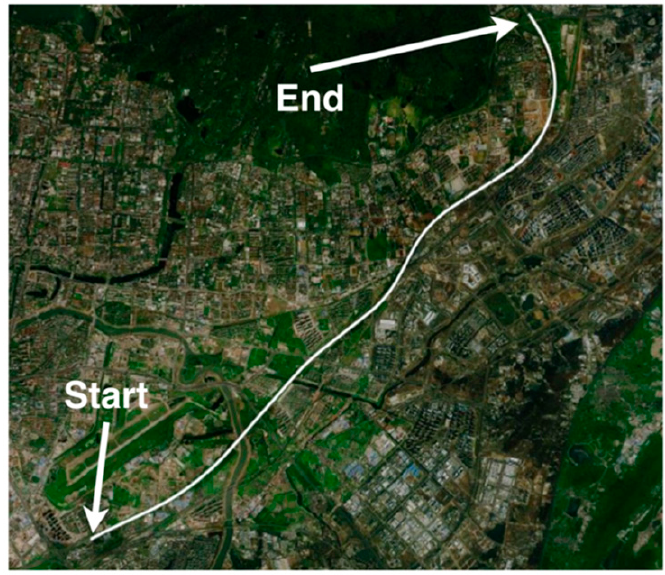
Figure 7. The in-motion trajectory of the vehicle.